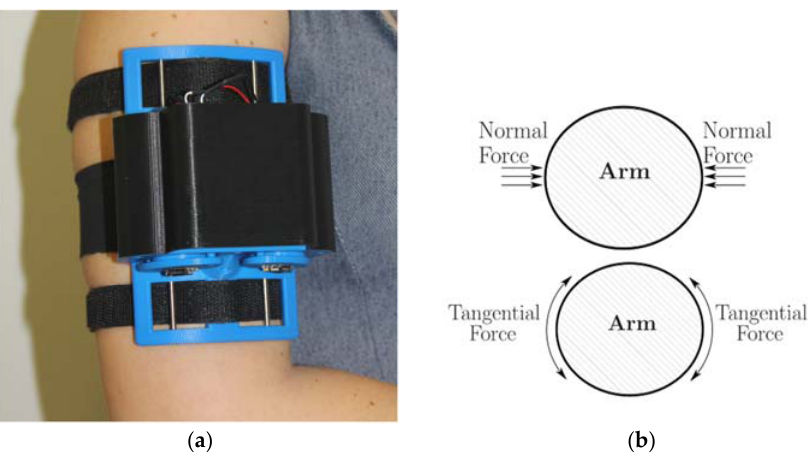
Figure 5. Clenching Upper ‐ limb Force Feedback (CUFF) ( a ) and working modes ( b ). The total weight